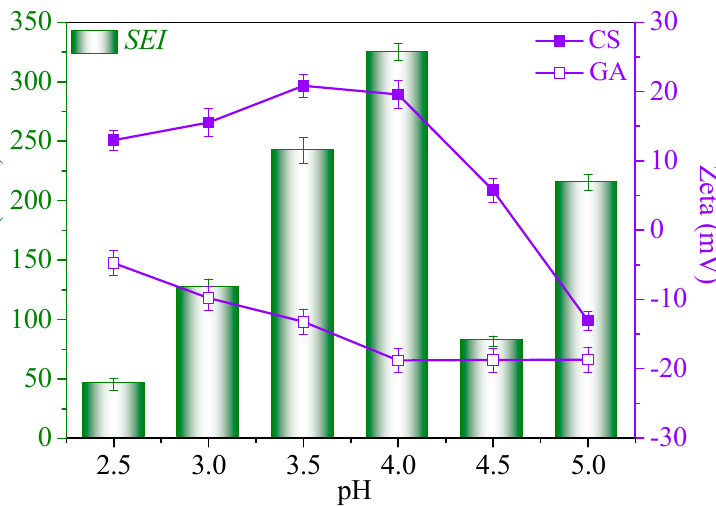
Figure 2. The zeta potentials (mV) and SEI (mV 2 ) measurement of the GA and SC in different pH values. Means of values obtained in triplicate ( p ≤ 0.05).